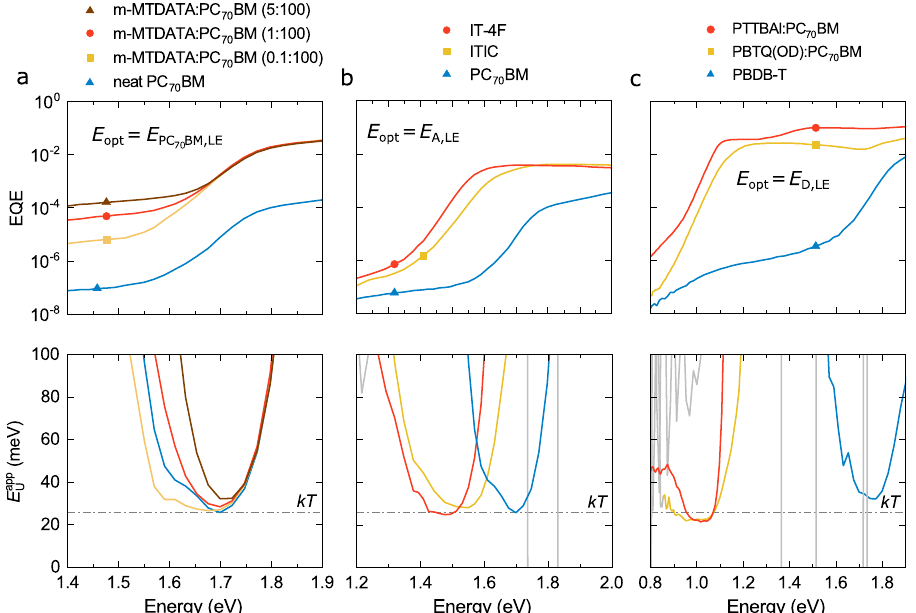
for a series of m-MTDATA sensitized PC 70 BM solar cells. The widest energy range Fig. 2 EQE tail dominated by neat material absorption. a , EQE and E app U over which E app equals kT is observed for 0.1 mol% m-MTDATA in PC 70 BM due to improved exciton dissociation in comparison to neat PC 70 BM. Examples U (cid:4) kT in some parts of the for EQE tails partially dominated by b , the neat donor absorption or by c , the neat acceptor absorption hence showing E app U spectrum. EQE spectra of PTTBAI:PC 70 BM and PBTQ(OD):PC 70 BM are taken from reference 35